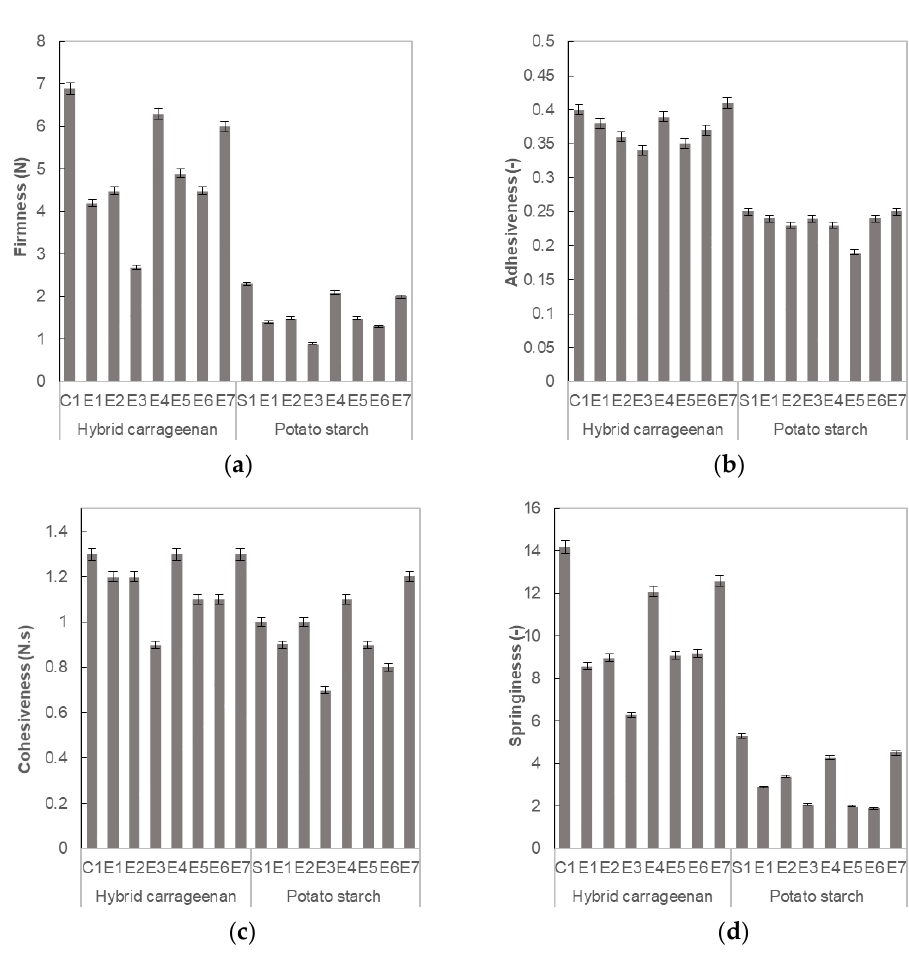
Figure 5. Texture parameters in terms of ( a ) firmness, ( b ) adhesiveness, ( c ) cohesiveness and ( d ) springiness for the proposed matrices prepared with hybrid carrageenan or potato starch in the presence of selected extracts (E1–E7; see Table 1). The controls prepared with hybrid carrageenan (C1) and potato starch (S1) were also included.